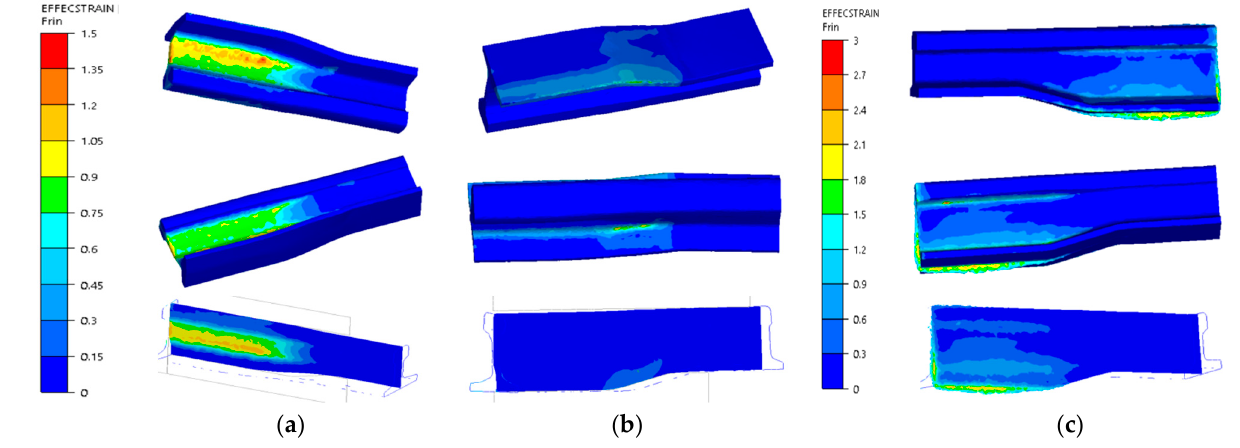
Figure 16. Deformation intensity distribution after the consecutive forging operations: ( a ) after operation I, ( b ) after operation II, ( c ) after operation III.